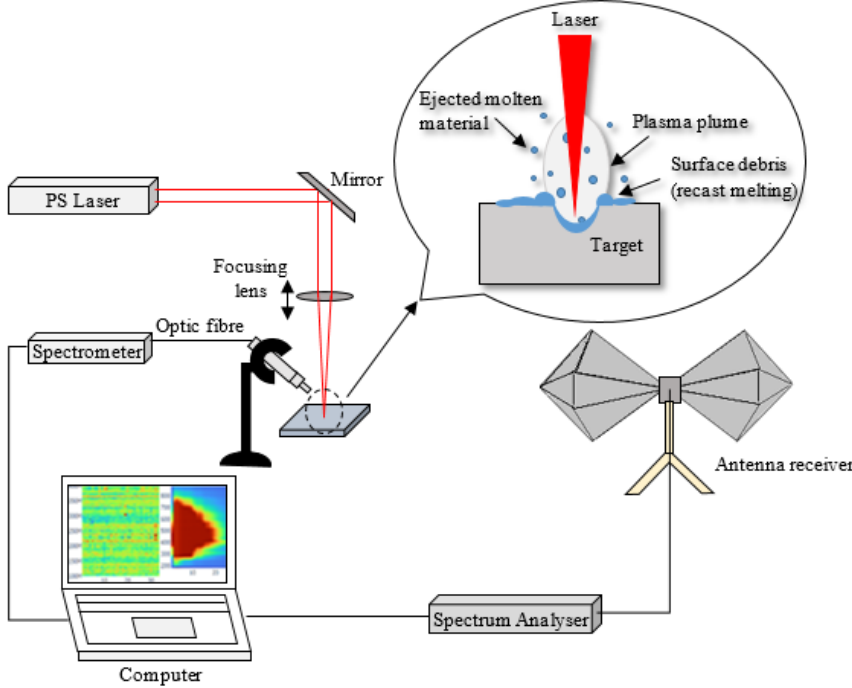
Figure 1. A diagram of the experimental setup.